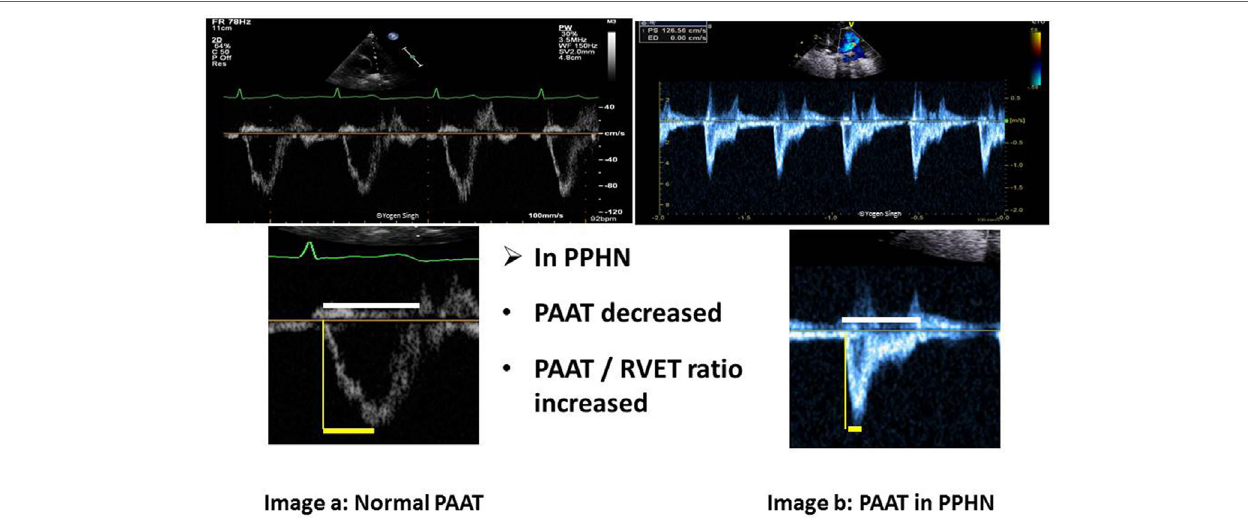
FiGURe 9 | Pulmonary artery acceleration time (PAAT) measurement. Image a shows normal ratio of PAAT and right ventricular ejection time (RVET) in a normal child. Image b shows significantly decreased PAAT and increased PAAT/RVET ratio suggestive of pulmonary hypertension. “Dicrotic notch” may be seen on pulse-wave Doppler spectral in the pulmonary artery.